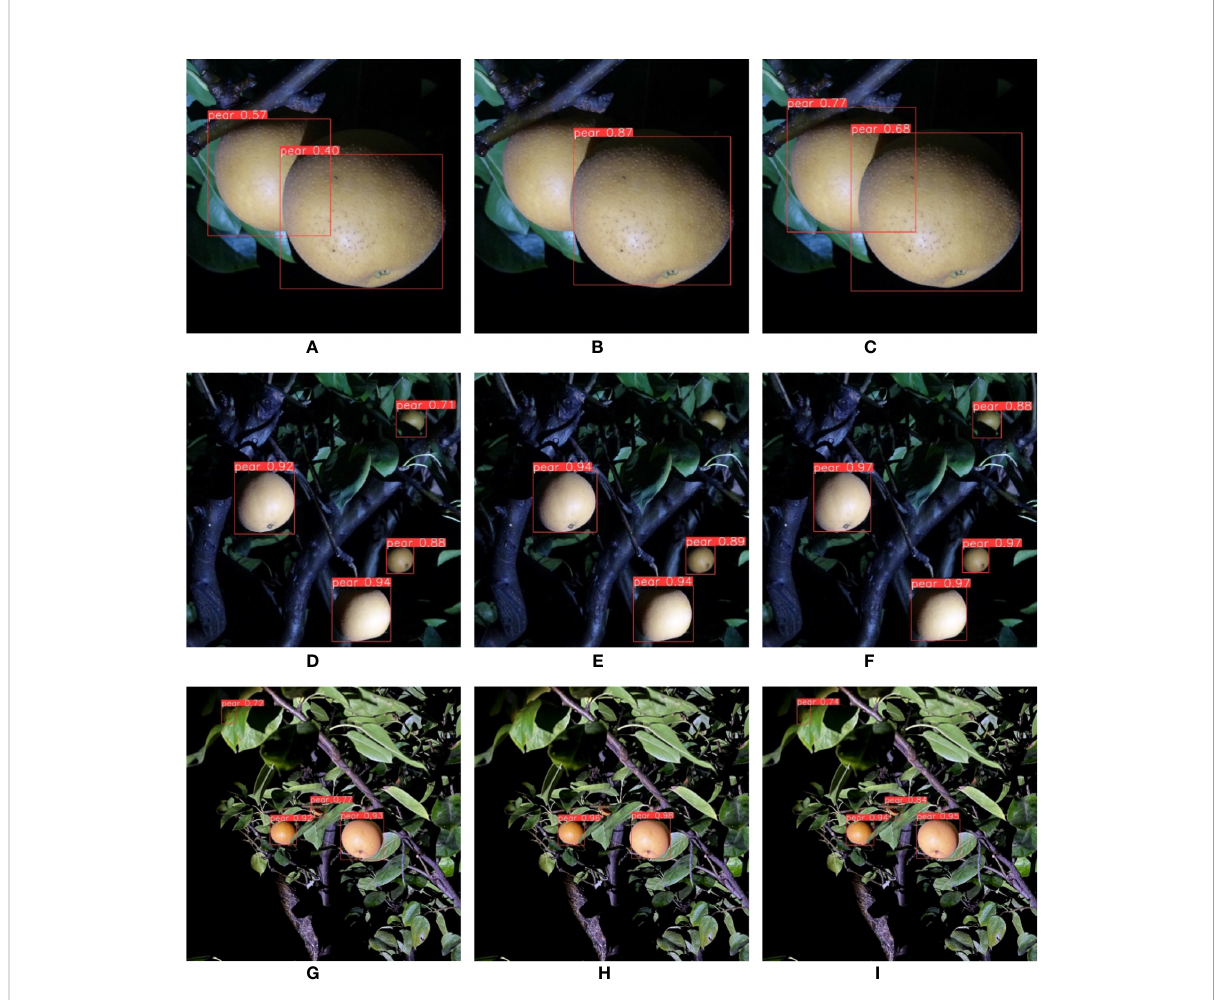
FIGURE 10 From left to right are the detection effects of YOLOv5s, MobileNet-YOLO and YOLO-P. (A – C) Uncomplicated background; (D – F) Moderately complex background; (G – I) Extremely complex